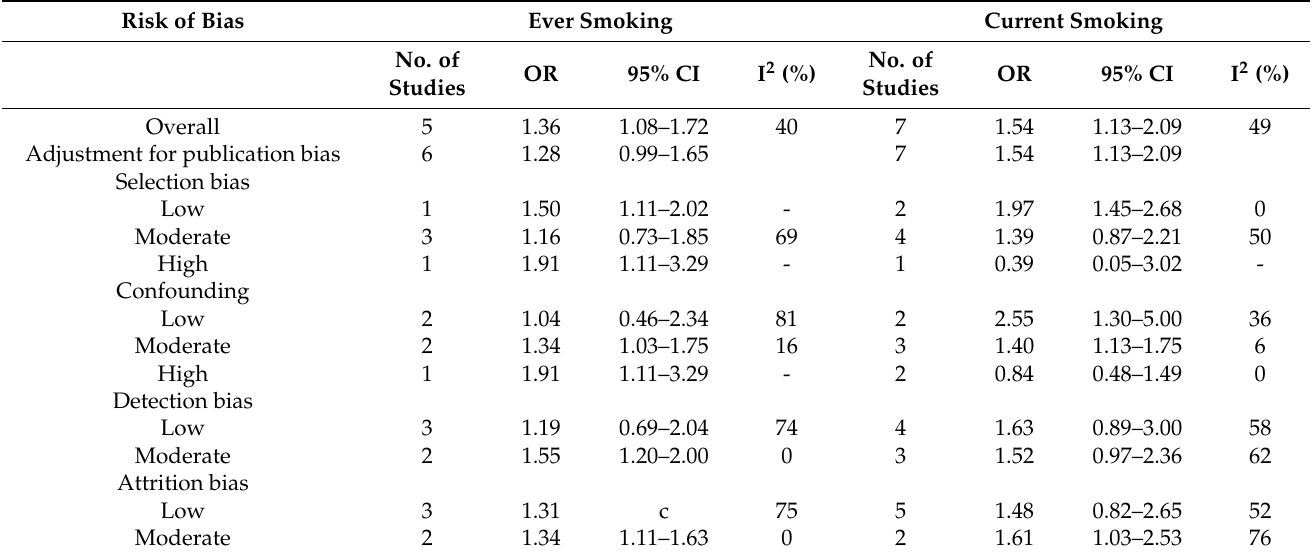
Table 2. Sensitivity analyses of cross-sectional studies on the associations of ever and current smoking with CTS, according to methodological quality of included studies and adjustment for publication